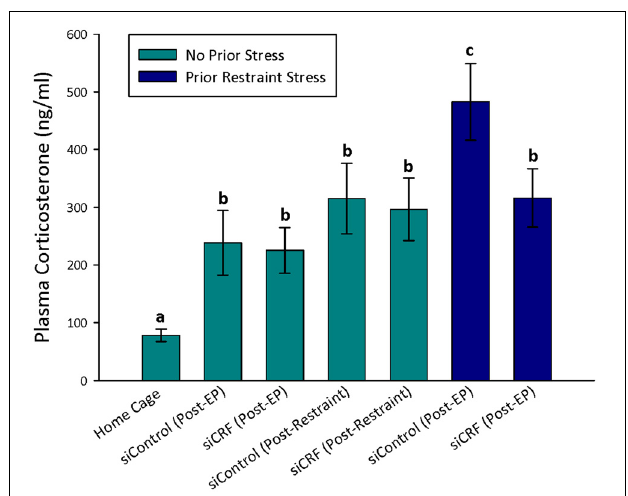
FIGURE 4 | Plasma corticosterone concentrations after restraint stress and EP testing in siContol and siCRF rats. Restraint stress and EPM induced a robust increase in corticosterone in both control and treatment rats ( p < 0 . 001). The highest concentrations of plasma corticosterone were found after EPM testing in rats that had received restraint stress 24h prior. This restraint stress sensitization of corticosterone response to a subsequent stressor was significantly attenuated by siRNA treatment ( p < 0 .